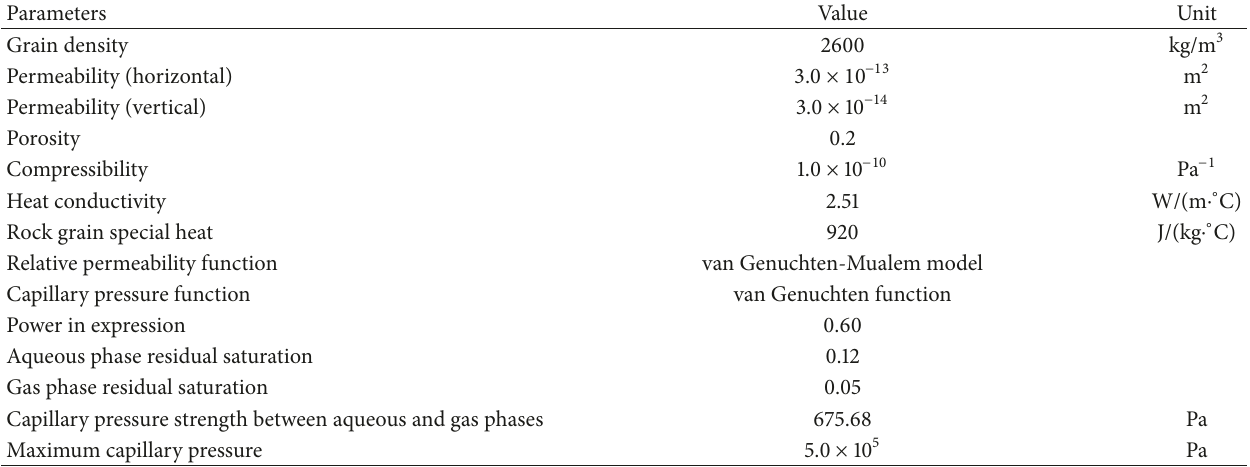
Table 1: List of the key parameters of the